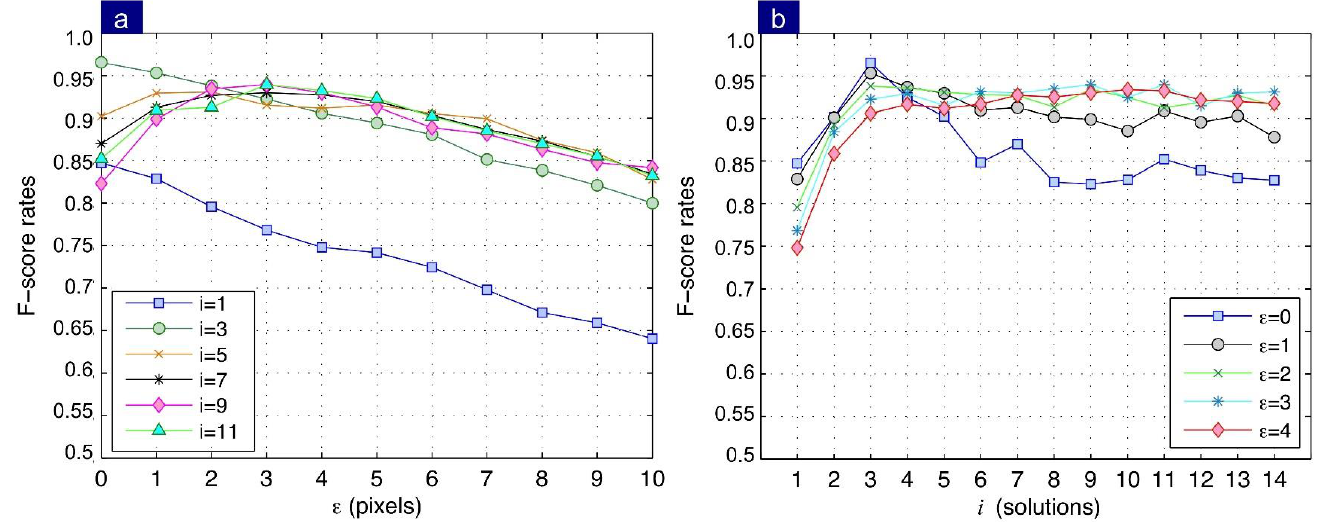
Figure 9. Average performance obtained in the outdoor image set: ( a ) The effect of ε in the method’s performance. ( b ) Influence of parameter i on performance as a function of 𝜀 .